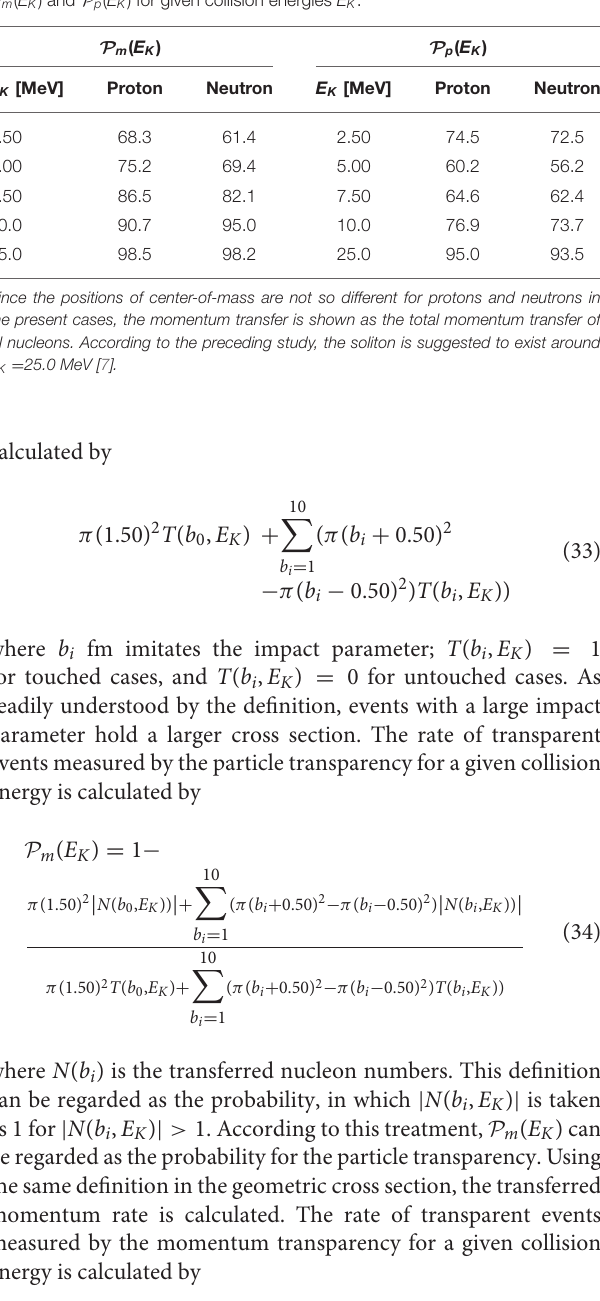
TABLE 3 | The observation probability [ % ] of soliton state of 4 He calculated by P m ( E K ) and P p ( E K ) for given collision energies E K